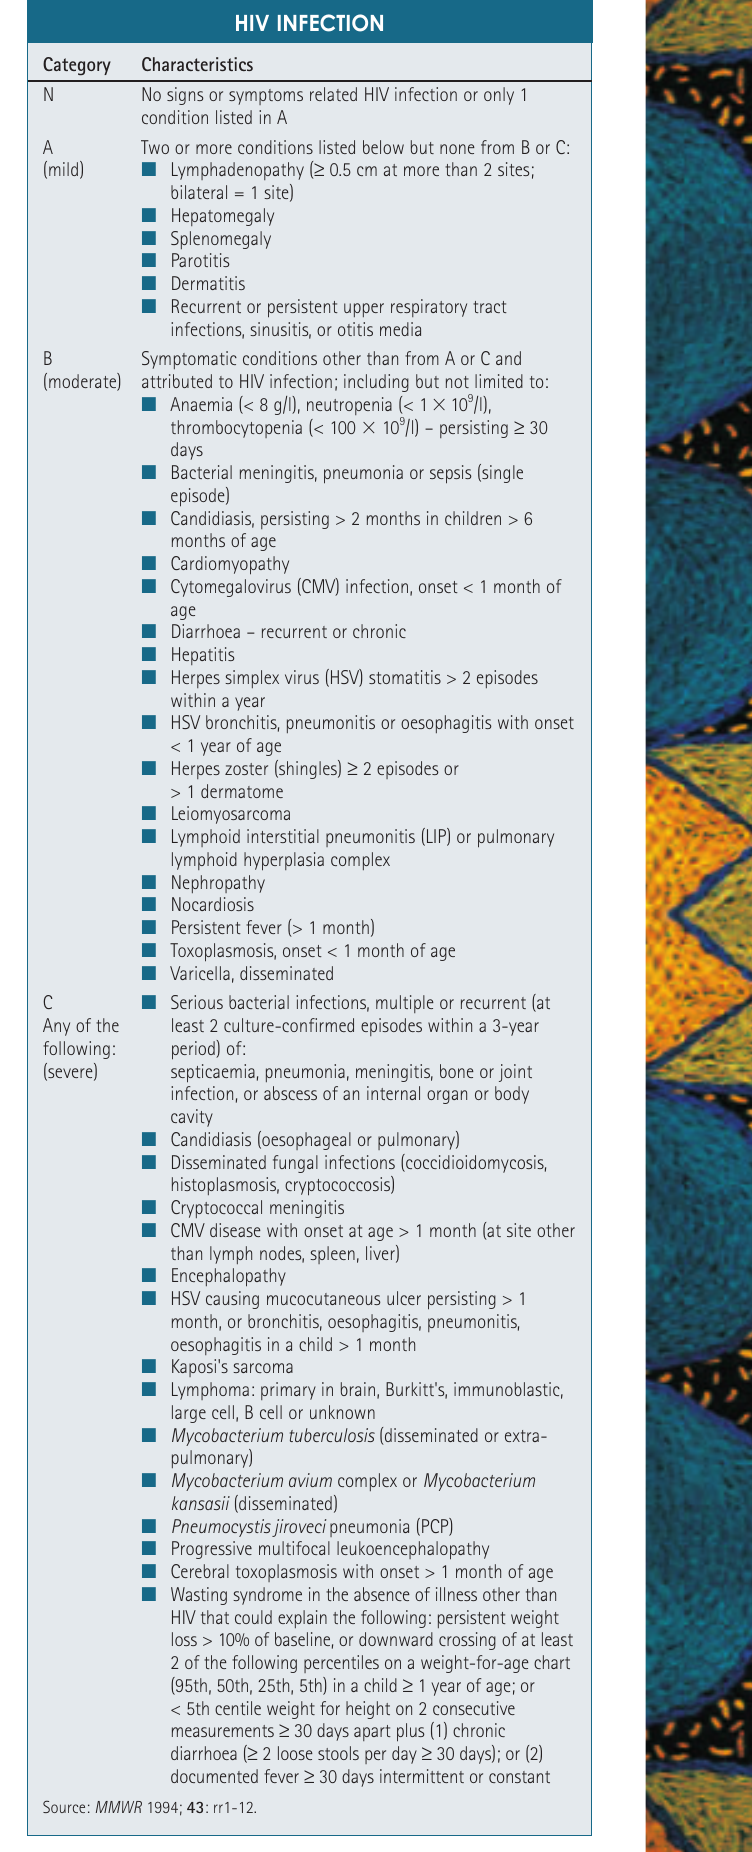
TABLE I. CLINICAL CATEGORIES FOR CHILDREN